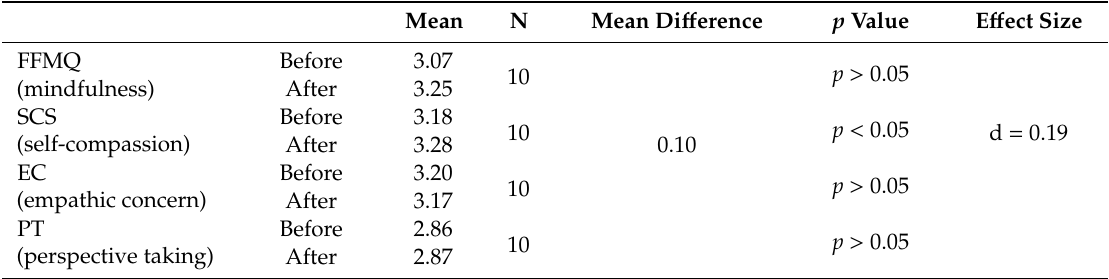
Table 3. Means, p -value, and e ff ect size of the control